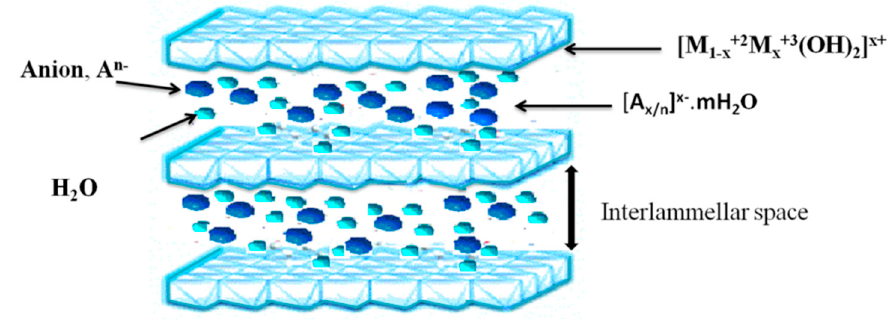
Figure 1. Schematic illustration of layered double hydroxides.